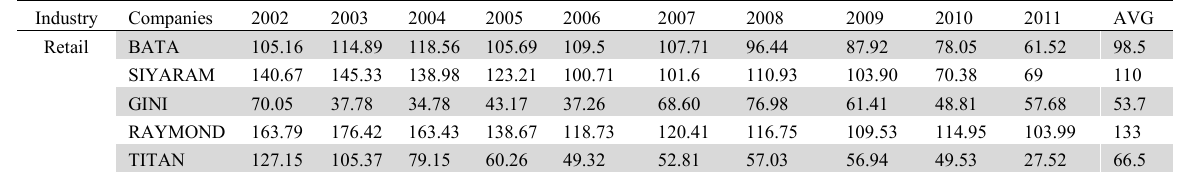
Analysis of cash conversion cycle of selected companies of retail sector